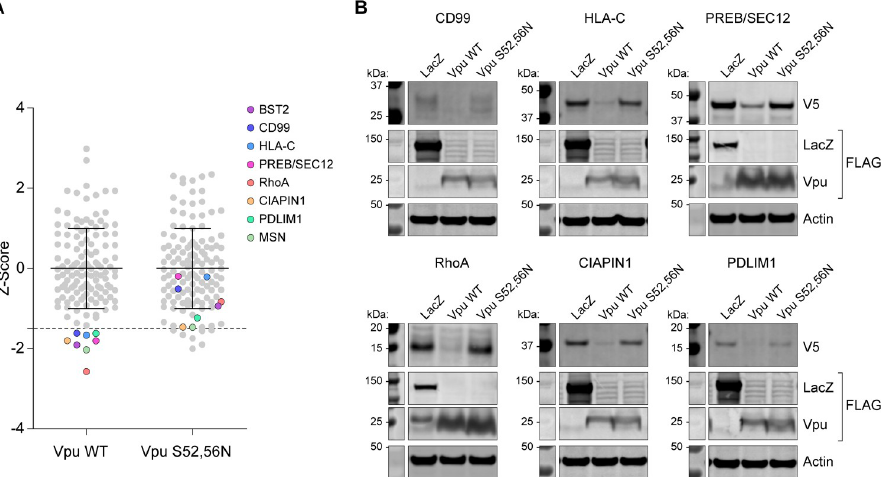
Fig 7. Proteins enriched in the proximity-ome of Vpu-S52,56N relative to wild type: Vpu-mediated and serine- dependent decreases in steady-state expression. (A) HEK293T cells were co-transfected with target cDNAs and plasmids expressing WT Vpu or Vpu-S52,56N. Levels of proteins were measured 48 hours later by immunofluorescent staining and automated quantification of fluorescence. Candidate Vpu targets whose expression is significantly decreased by Vpu are colored. (B) Vpu-mediated degradation of putative target proteins was tested by western blotting of exogenously-expressed cDNA targets.